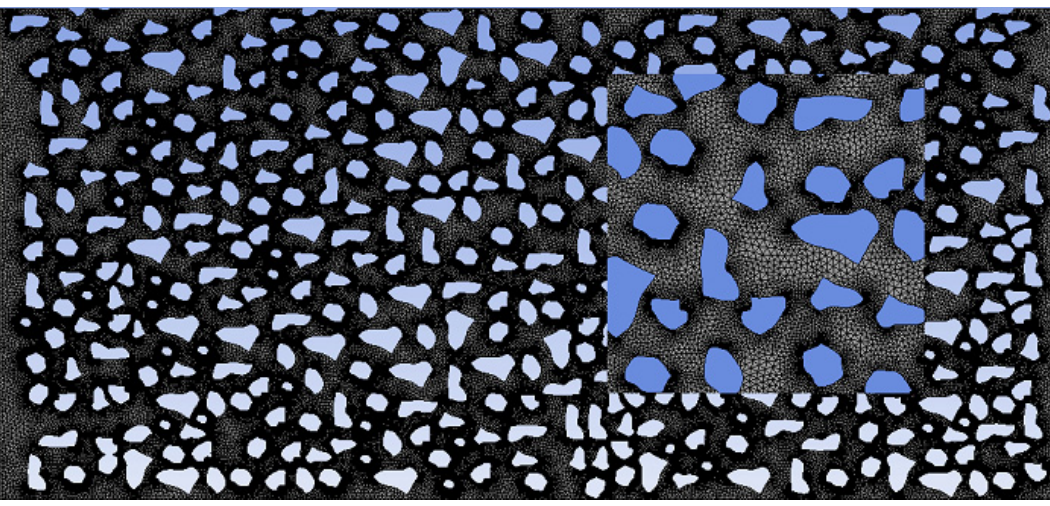
Figure 3. Detail of the mesh for the micromodel (d).